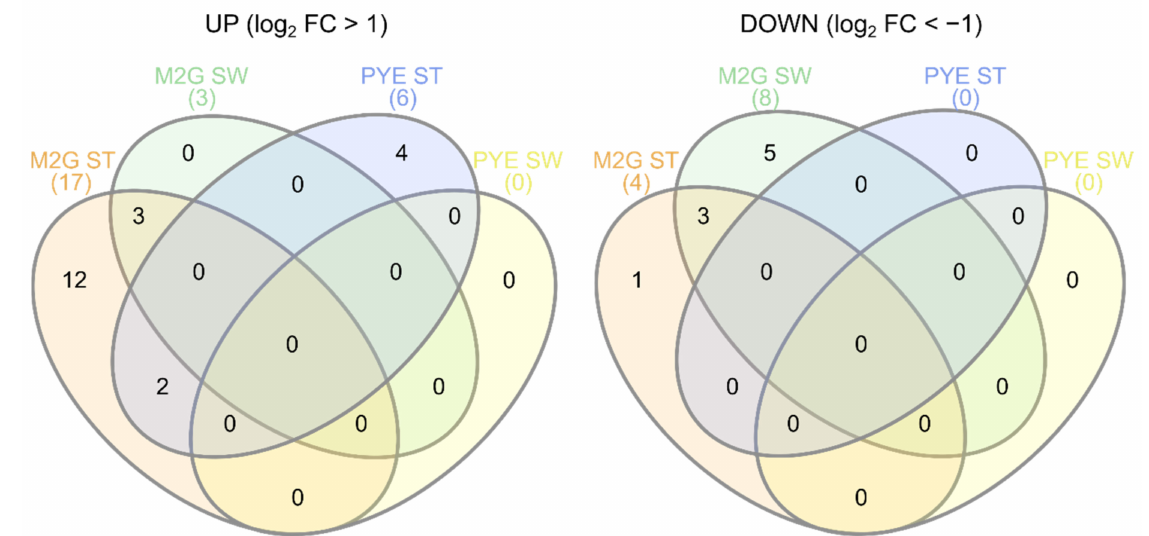
Figure 8. Venn diagrams showing overlap between sRNAs upregulated ( left ) and downregulated ( right ) by Cu stress in all experimental